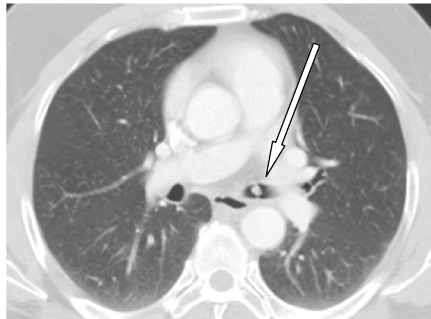
Figure 2: Axial CT of chest (lung window) at the level of left main pulmonary artery showing a pedunculated mass 0.5 cm in the left main bronchus (white